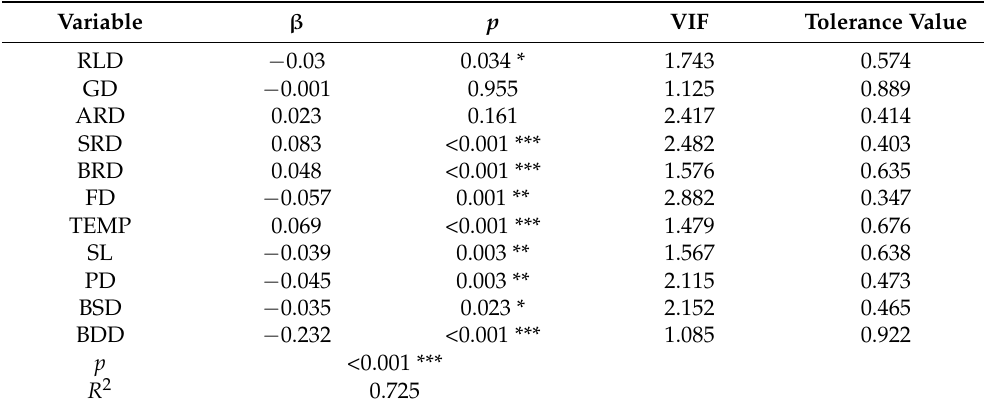
Table 4. Multiple linear regression analysis and multicollinearity test of footpath environment and residents’